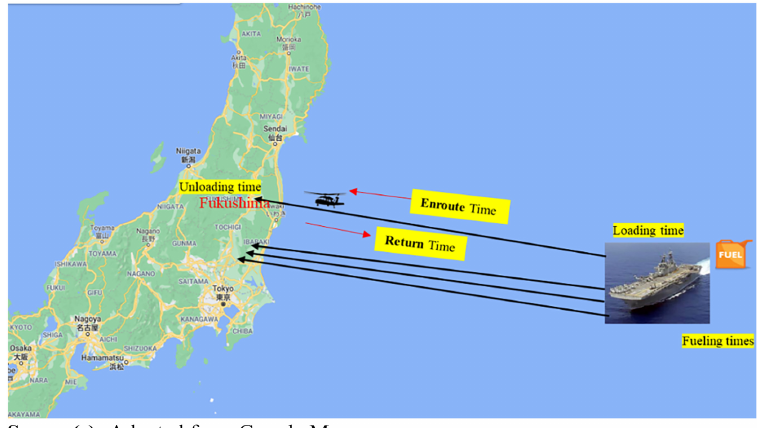
operation based on Japan Disaster